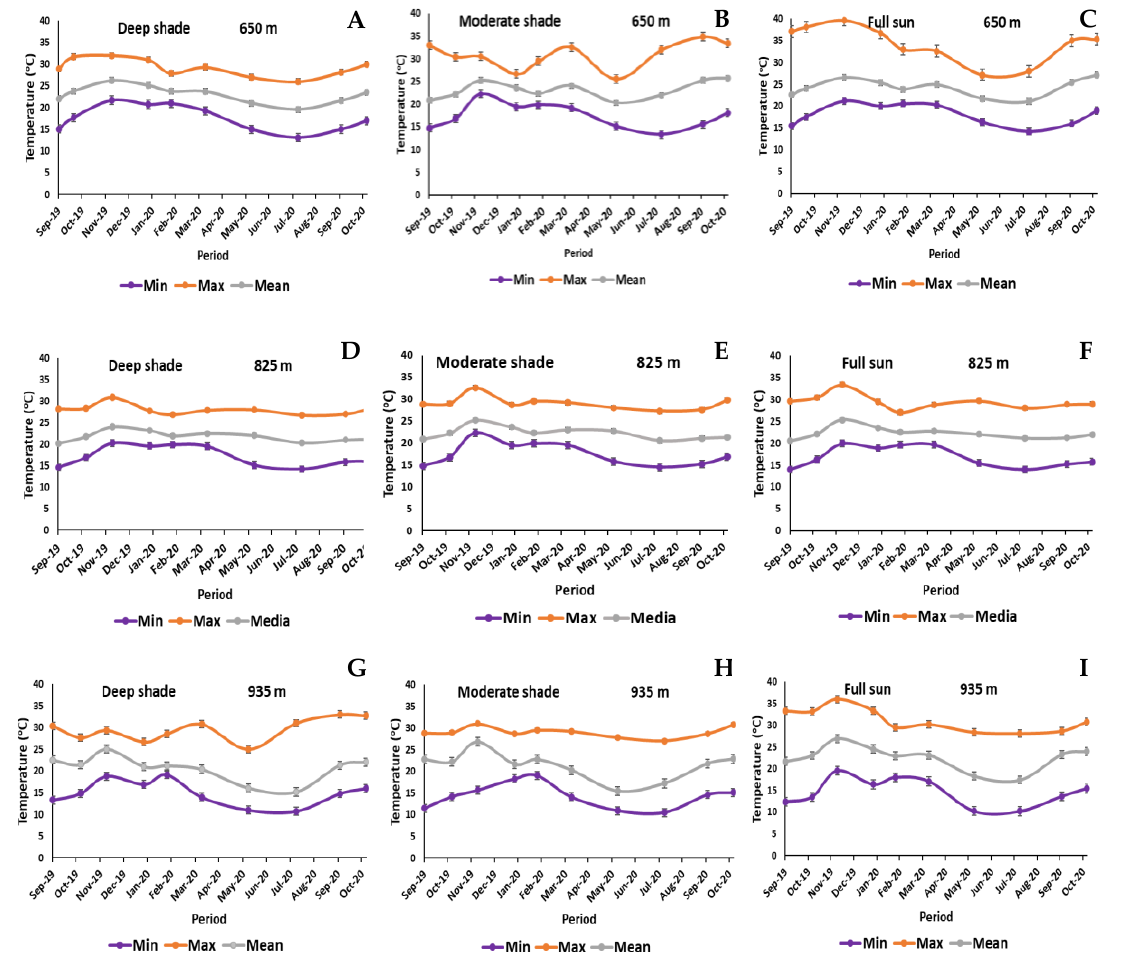
Figure 2. Maximum, mean and minimum air temperatures measured, under three light exposure conditions (deep shade, moderate shade and full Sun) and three altitudes (650 m, 825 m and 935 m) in the experimental area of Gorongosa Mountain, obtained with temperature sensors (ONSET, Pro v2 Logger U23-00x), installed in each of the three altitudes and three light conditions. Each point represent the mean ± SE (n = 30).